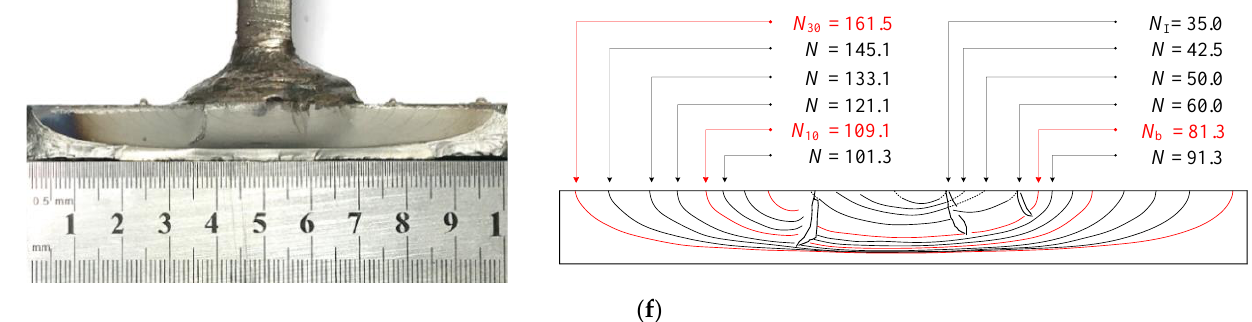
Figure 10. Beach marks on fracture surfaces ( N : × 10 4 cycles). ( a ) W1-2. ( b ) W3-2. ( c ) W4-2. ( d ) W5-2. ( e ) C1-1. ( f ) C2-2.